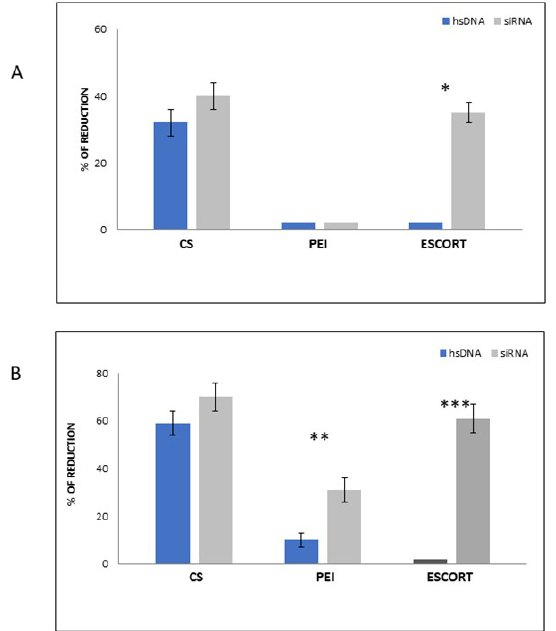
Figure 10. Percentage of HIV-1 RNA reduction in C8166 cell line treated for 4 h pre ( A ) and post ( B ) single cycle HIV-1 infection, by PCR analysis. Both cell lines were treated with each nano delivery system (CS and control systems) loaded with both hsDNA and siRNA tat/rev at N/P = 10, with 20 µg/mL. * p = 0.0015; ** p = 0.0001; *** p < 0.0001 (Chi-square test). In particular, when using CS-based vectors, it seems that both using CS/hsDNA model system and CS/siRNA in transfection experiments in the pre-infection mode, we